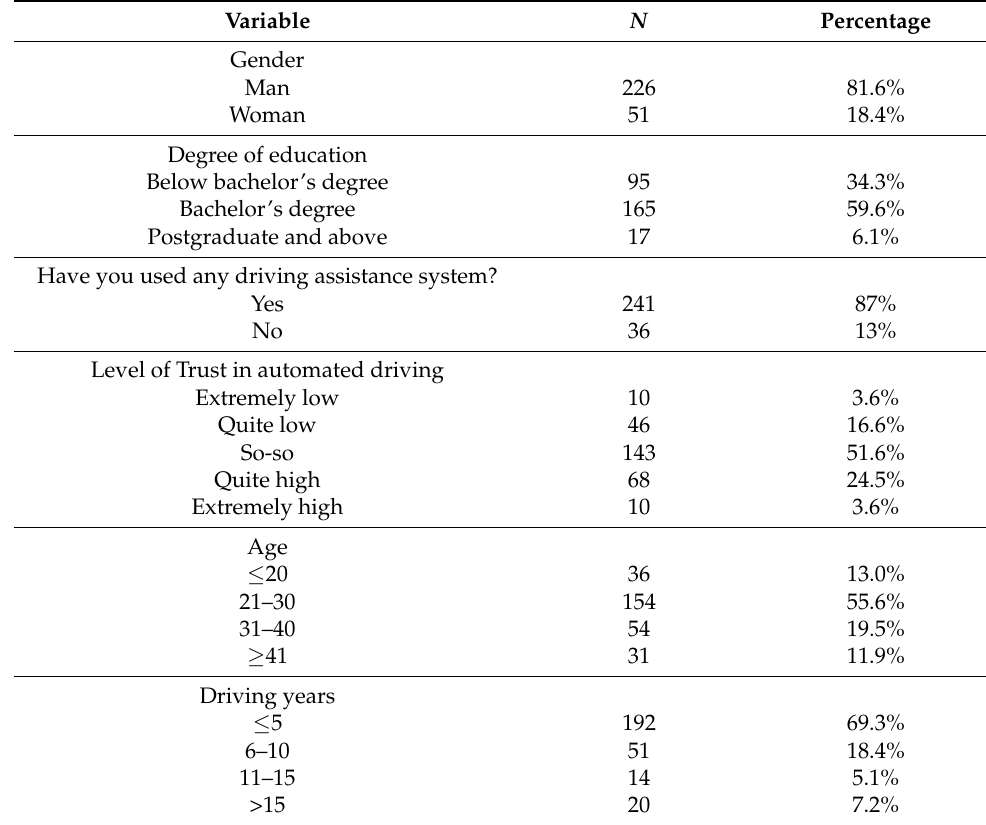
Table 1. Statistical table of basic information of